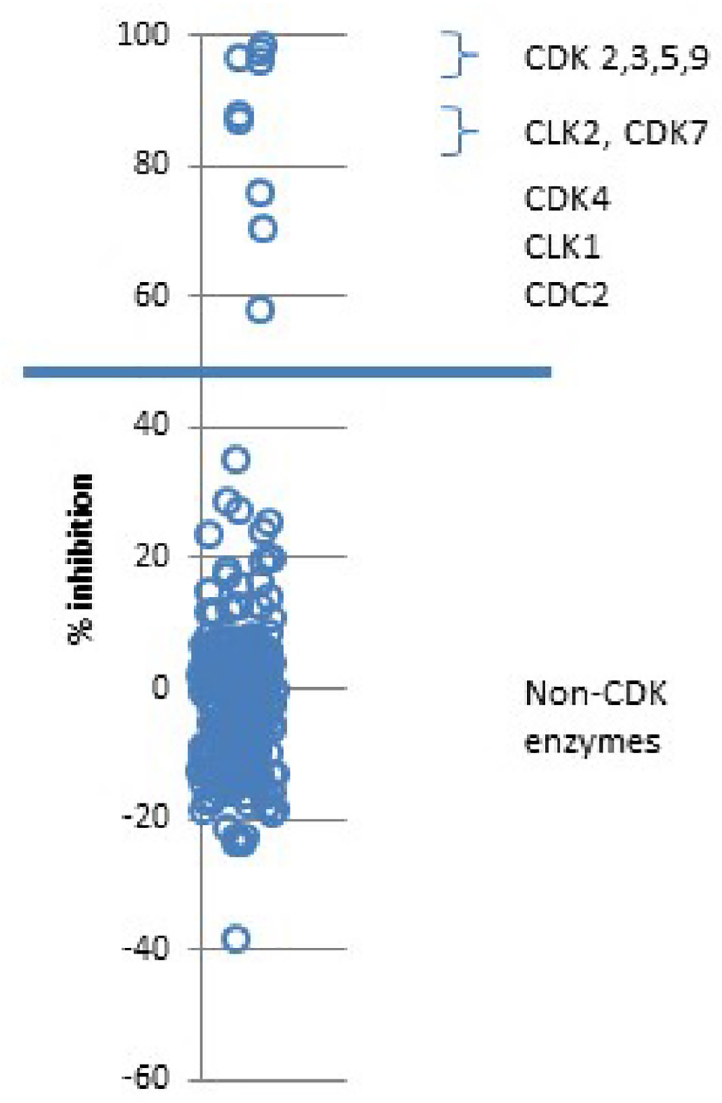
Fig 2. In vitro CDK selectivity of fadraciclib (CYC065). Fadraciclib (CYC065) (1 μ M) was profiled against a 256 kinase selectivity panel. The value obtained for the reaction control (complete reaction mixture) was set at 0% inhibition, and the value of the background (no enzyme) was set as 100% inhibition. Percentage inhibition of each enzyme by fadraciclib (CYC065) is indicated in the graph. Nine CDK and CDK-like enzymes were inhibited greater than